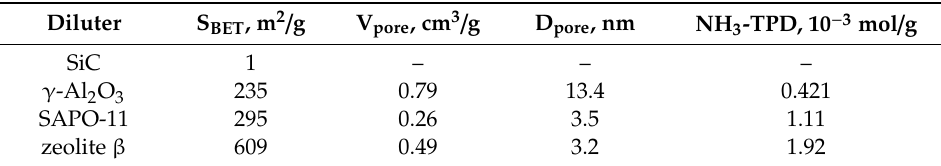
Table 2. Physicochemical properties of the